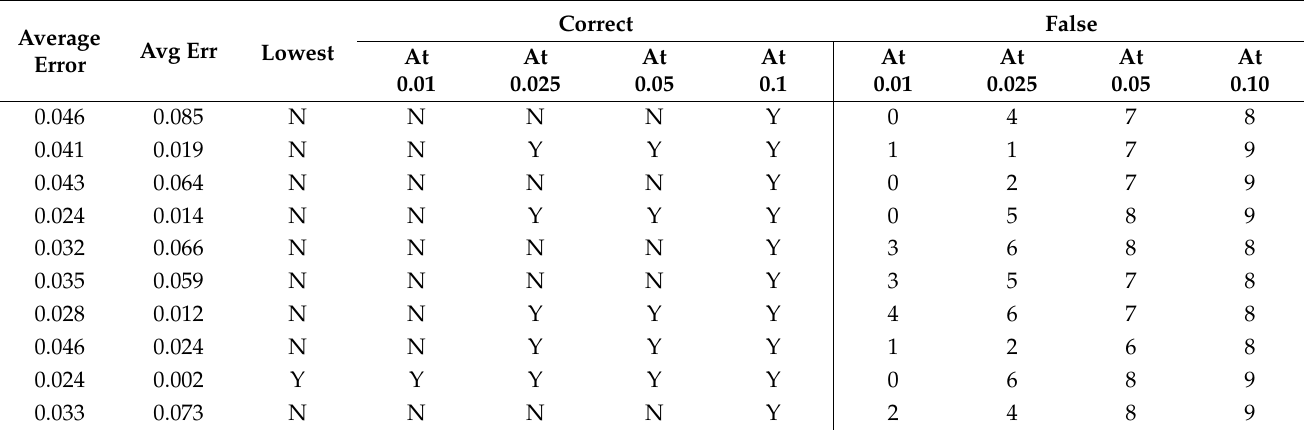
Table A29. Set 1, trials 11–20 summary data (single 0.5 PR